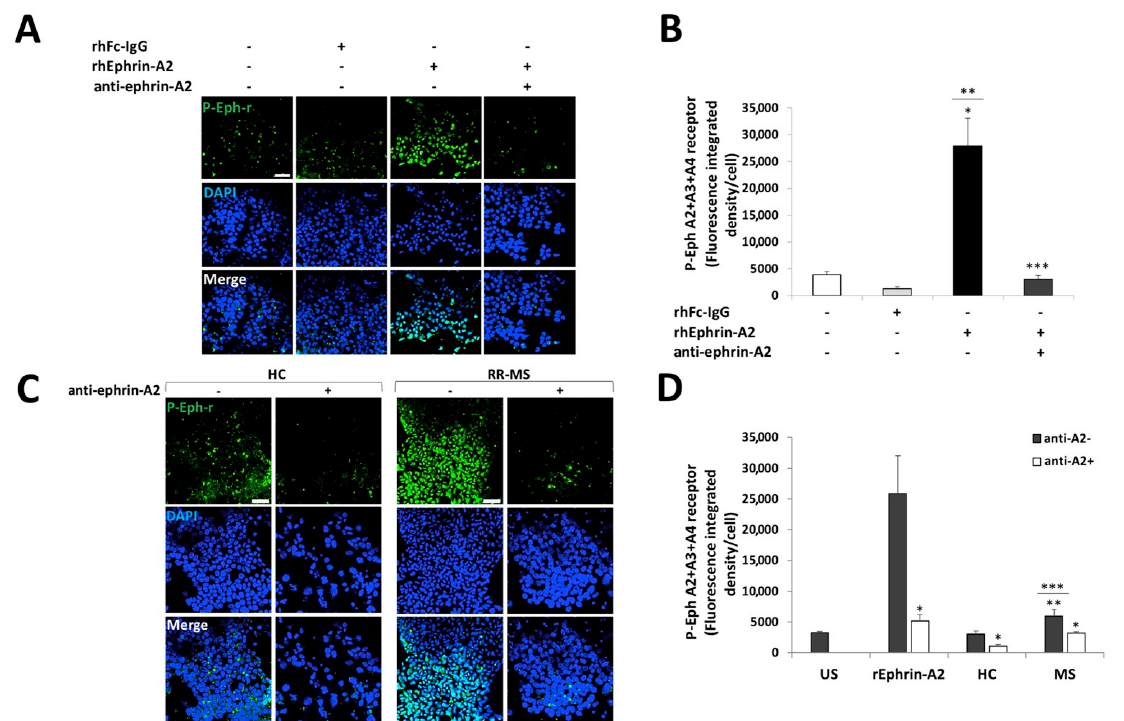
Figure 3. Immune cells of patients with RR-MS increased EphA-receptor phosphorylation in a co-culture bioassay. HEK-293T cells were unstimulated or stimulated with recombinant proteins or co-cultured with immune cells of HC or RR-MS patients and immunostained to phosphorylated Eph A2+A3+A4-receptors (p-Eph-r) and DAPI nuclear staining. ( A ) Representative confocal microscopy images of HEK-293T cells unstimulated or stimulated with 0.5 µg/mL of recombinant human Fc-IgG negative control (hrFc IgG), 0.5 µg/mL human recombinant ephrin-A2 (hrEphrin-A2) protein, and pre-incubated with or without 20 µ g/mL anti-ephrin-A2 blocking antibody against ephrin-A2 (anti-ephrin-A2). Magnification × 20; scale = 50 µ m. ( B ) Average of the Eph-receptor phosphorylation analysis shown in A. p < 0.05, * p value of hrEphrin-A2 vs. unstimulated (US), ** p value of hrEphrin-A2 vs. hrFc IgG, *** p value of hrEphrin-A2 vs. hrEphrin-A2+ anti-ephrin-A2. ( C ) Representative confocal microscope images of immunofluorescence staining for p-Eph-r of 293T-HEK cells co-cultured with immune cells of HC or RR-MS patients − /+ anti-ephrin-A2 antibody. Magnification × 20; scale = 50 µ m. ( D ) Average of the Eph-receptor phosphorylation analysis shown in ( C ). * p value without vs. with anti-ephrin-A2, ** p value of MS vs. US, *** p value of MS vs.